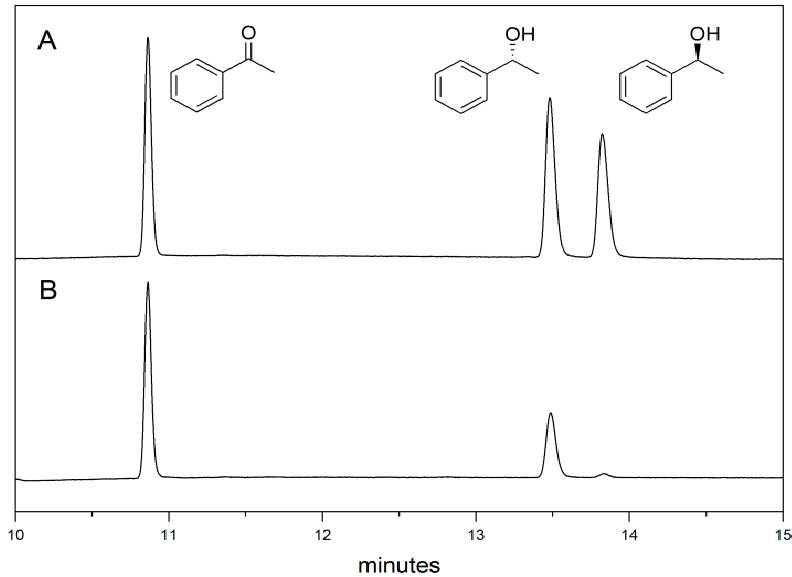
Figure 2. Microbial asymmetric reduction of acetophenone using whole cells of TQ-2 strain. ( A ): the standard substrate and alcohol products; ( B ): the products of acetophenone conversion catalyzed using TQ-2 whole cells .